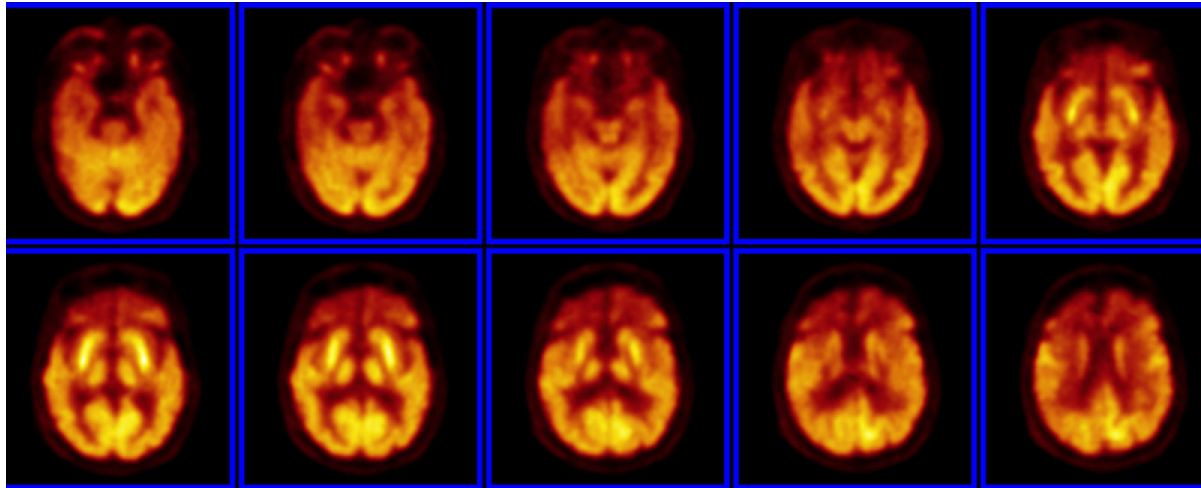
Figure 4. FDG-PET of a patient with a clinical picture of subtle change in behavior and other cognitive impairments suggestive of frontotemporal dementia (FTD). Note the marked reduced glucose uptake in the frontal lobes and in the anterior portion of the temporal lobes. A suggestive PET finding of FTD.